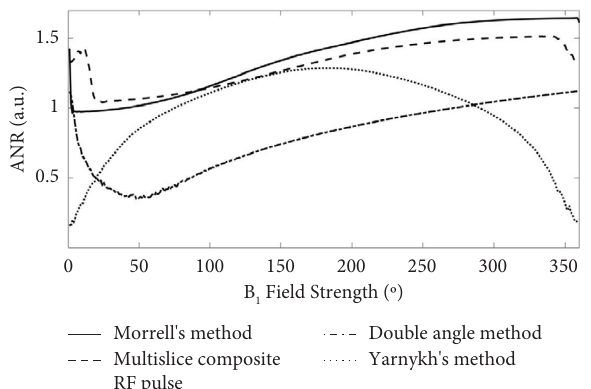
Figure 4: One-dimensional angle-to-noise ratio profles of the single slice acquisition for the double angle method, multislice composite RF pulse method (proposed B 1 mapping method), Morrell’s method, and Yarnykh’s